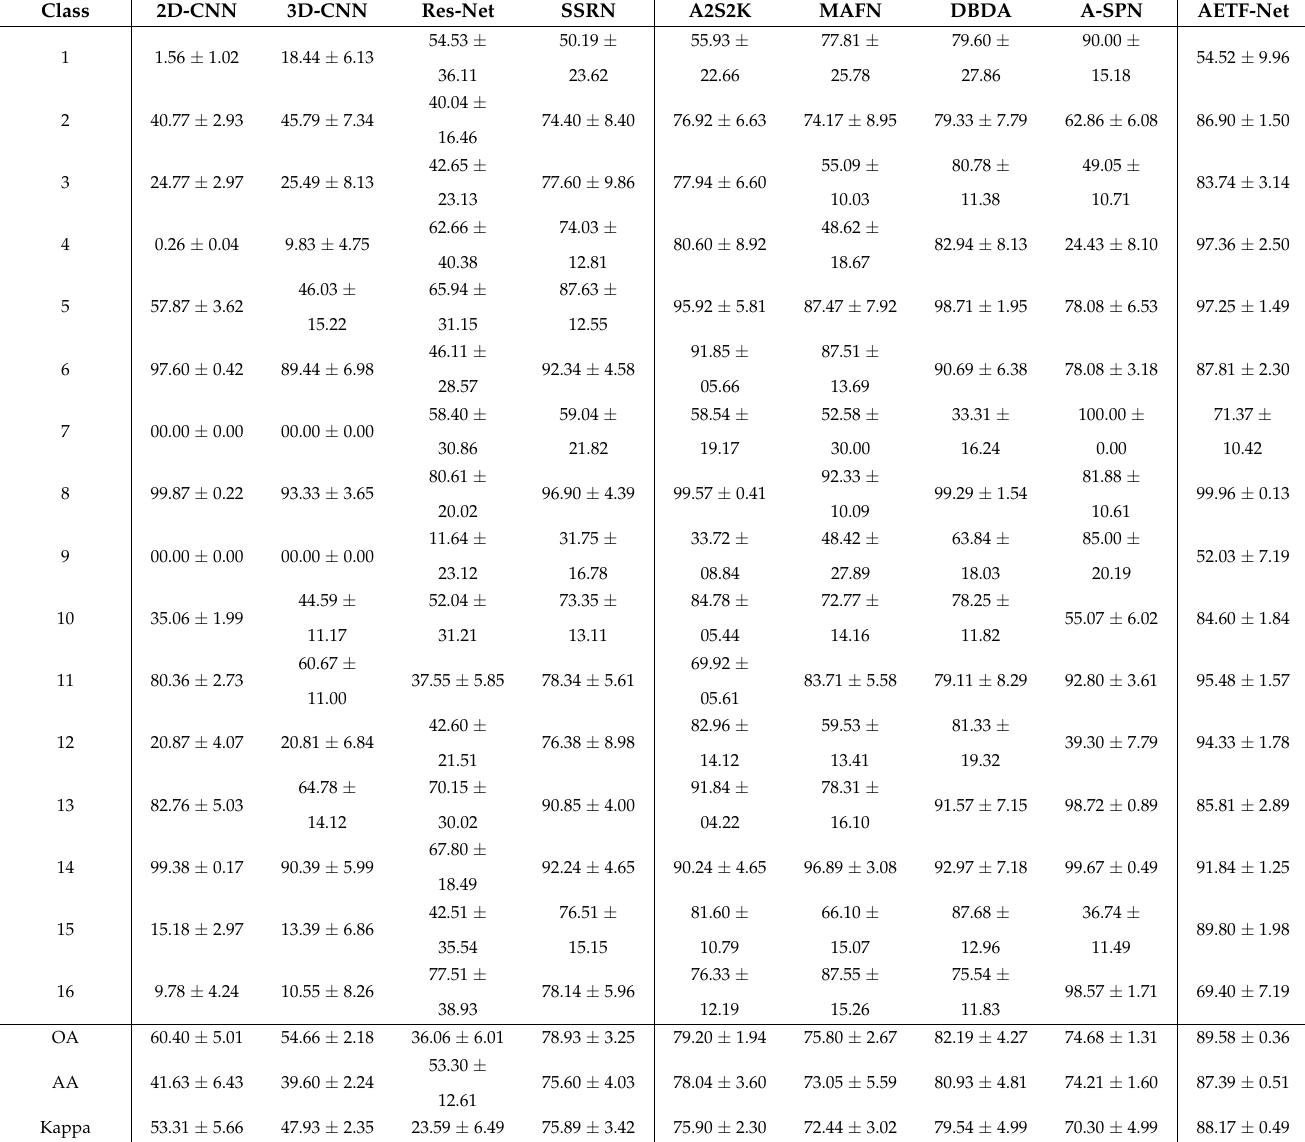
Table 5. The classification results (%) of all compared methods on the IP